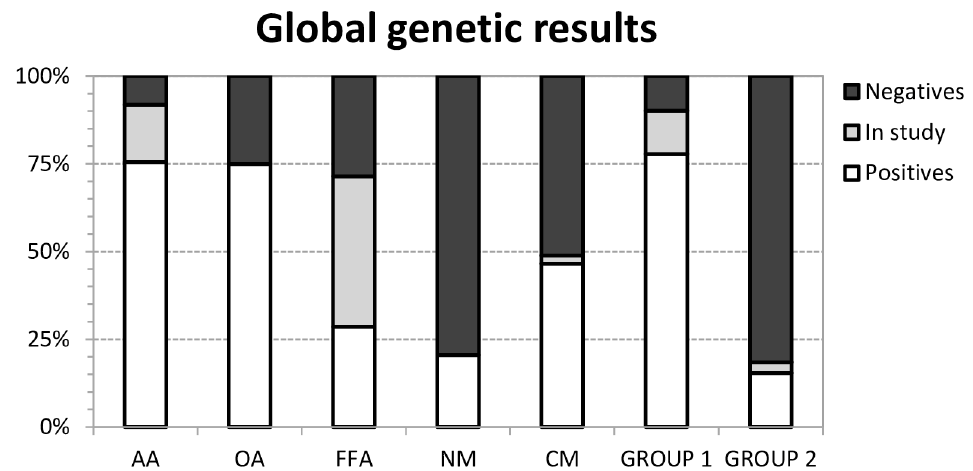
Fig 1. Global genetic results. Genetic results (positive, under-study, and negative cases) shown as a percentages for each nosological group (aminoacidopathies (AA); organic acidurias (OA); free fatty acid oxidation defects (FFA); and neurometabolic (NM) and complex molecules (CM) defects) and for both diagnostic groups (Groups 1 and